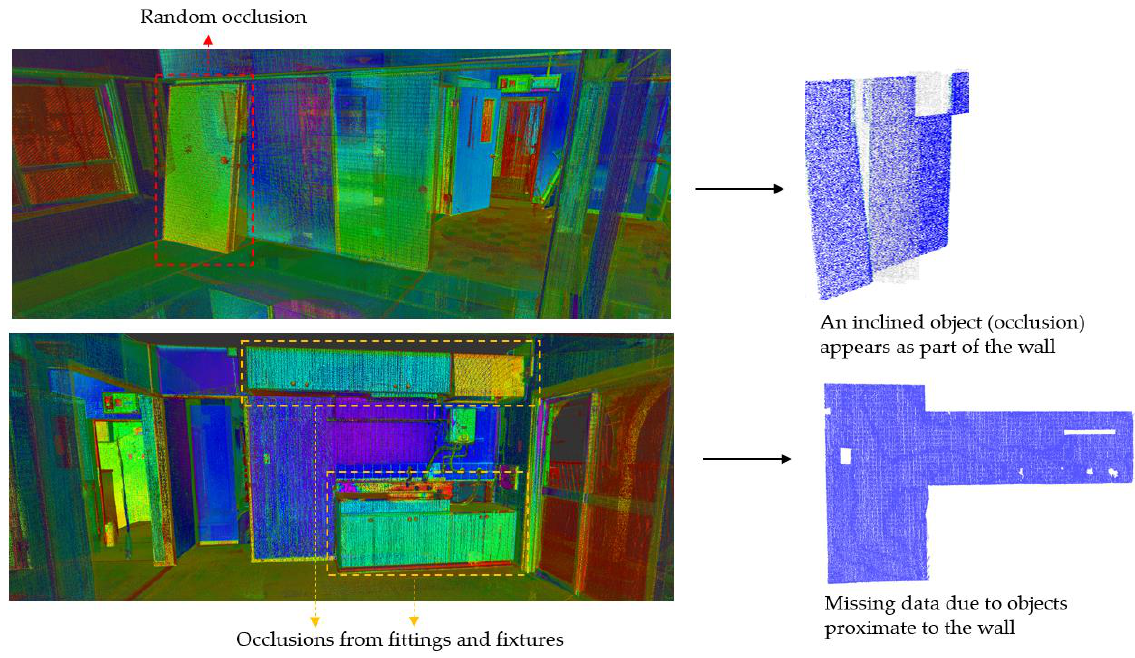
Figure 7. Presence of occlusions along the walls.